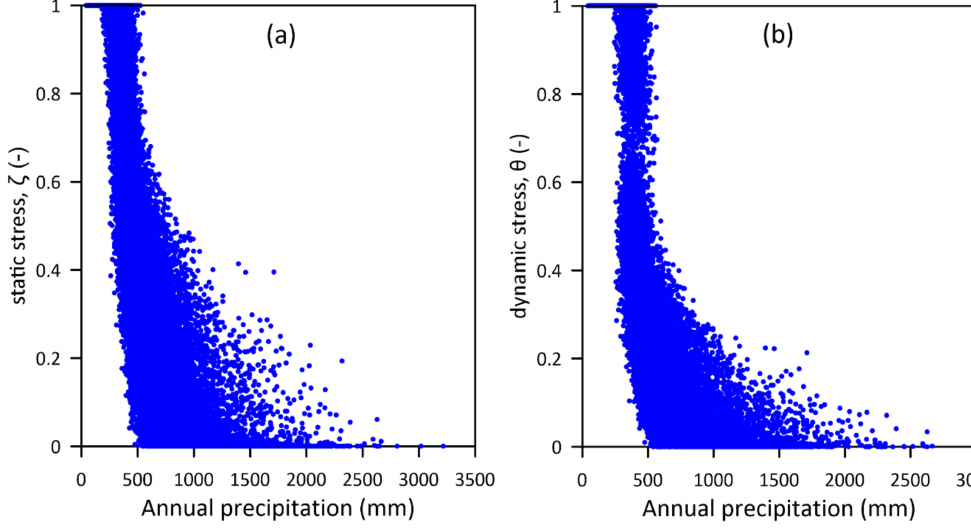
Figure 6. Relation between annual precipitation and ( a ) dynamic and ( b ) static stress for all sites and studied years